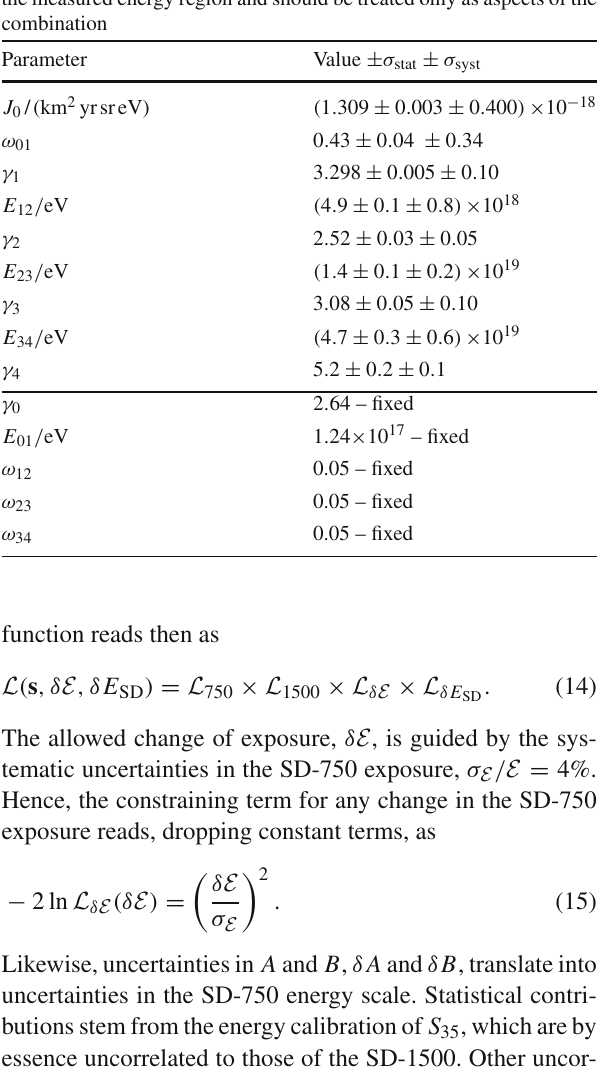
Table 7 Best-fit values of the combined spectral parameters (Eq. (13)). The parameter ω 12 , ω 23 and ω 34 are fixed to the value constrained in [21]. Note that the parameters γ 0 and E 01 correspond to features below the measured energy region and should be treated only as aspects of the